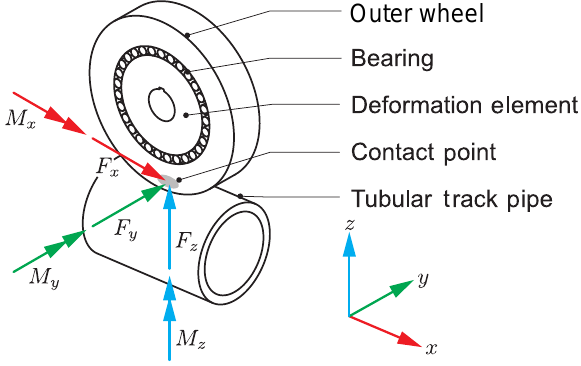
Figure 3. Measurement wheel with all acting forces and moments at the contact